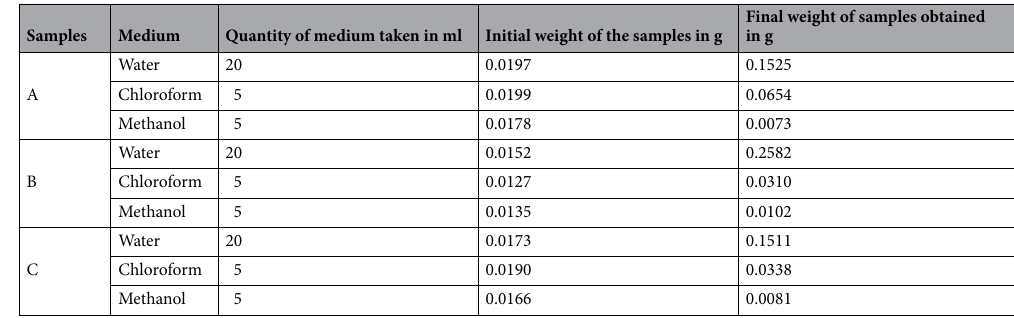
Table 4. Indicating the swelling test results in different solvent system.